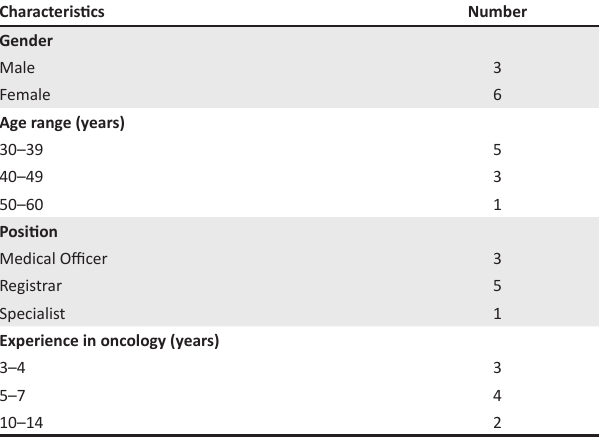
TABLE 1: Biographical information of participants.